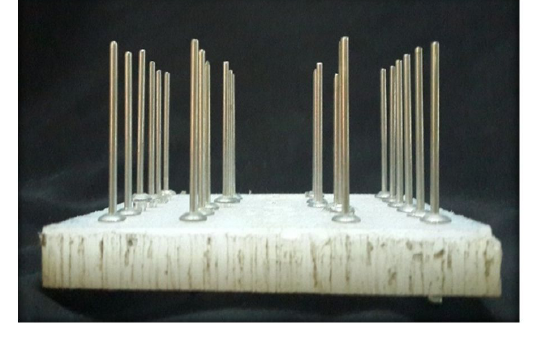
Figure 1: Plastic holding